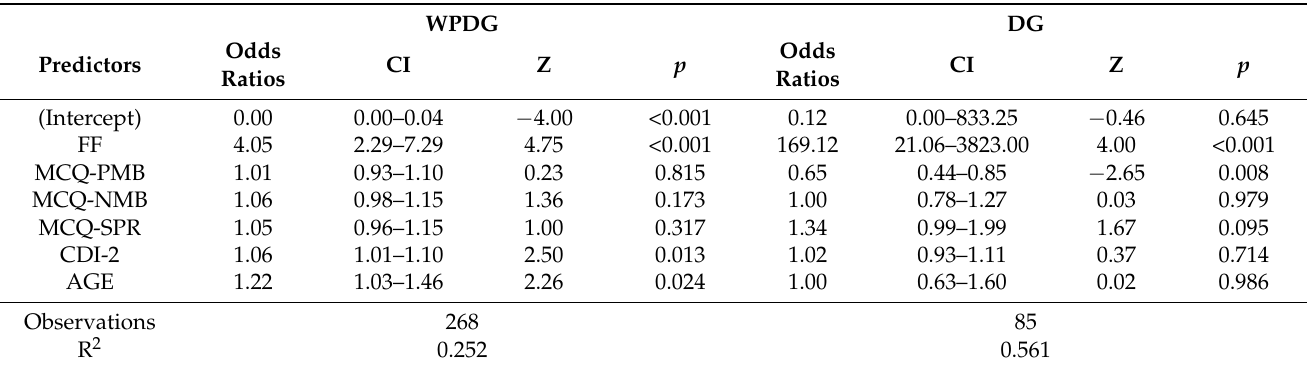
Table 3. Results of the multivariate logistic regression analysis on well-being.